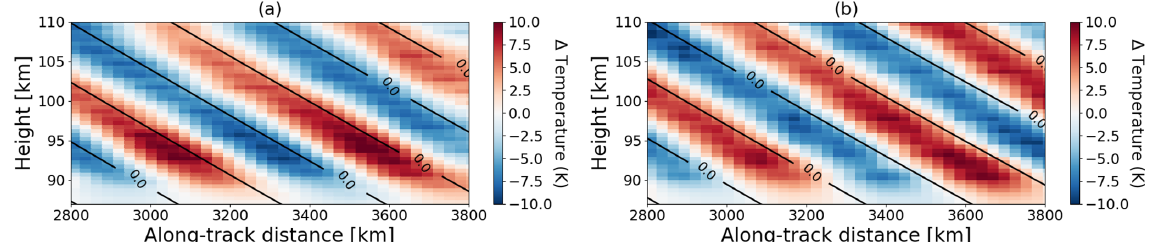
Figure 11. Comparison of wave structured retrieved in the along-track direction using a turning angle of 45 ◦ (a) and 90 ◦ (b) . The wave is simulated with a vertical wavelength of 15km and a horizontal wavelength of 425km. The wave vector is tilted at an angle of 32 ◦ away from the flight direction. The simulated wave amplitude is 10K. The phase fronts with zero value of the simulated wave are indicated by the black